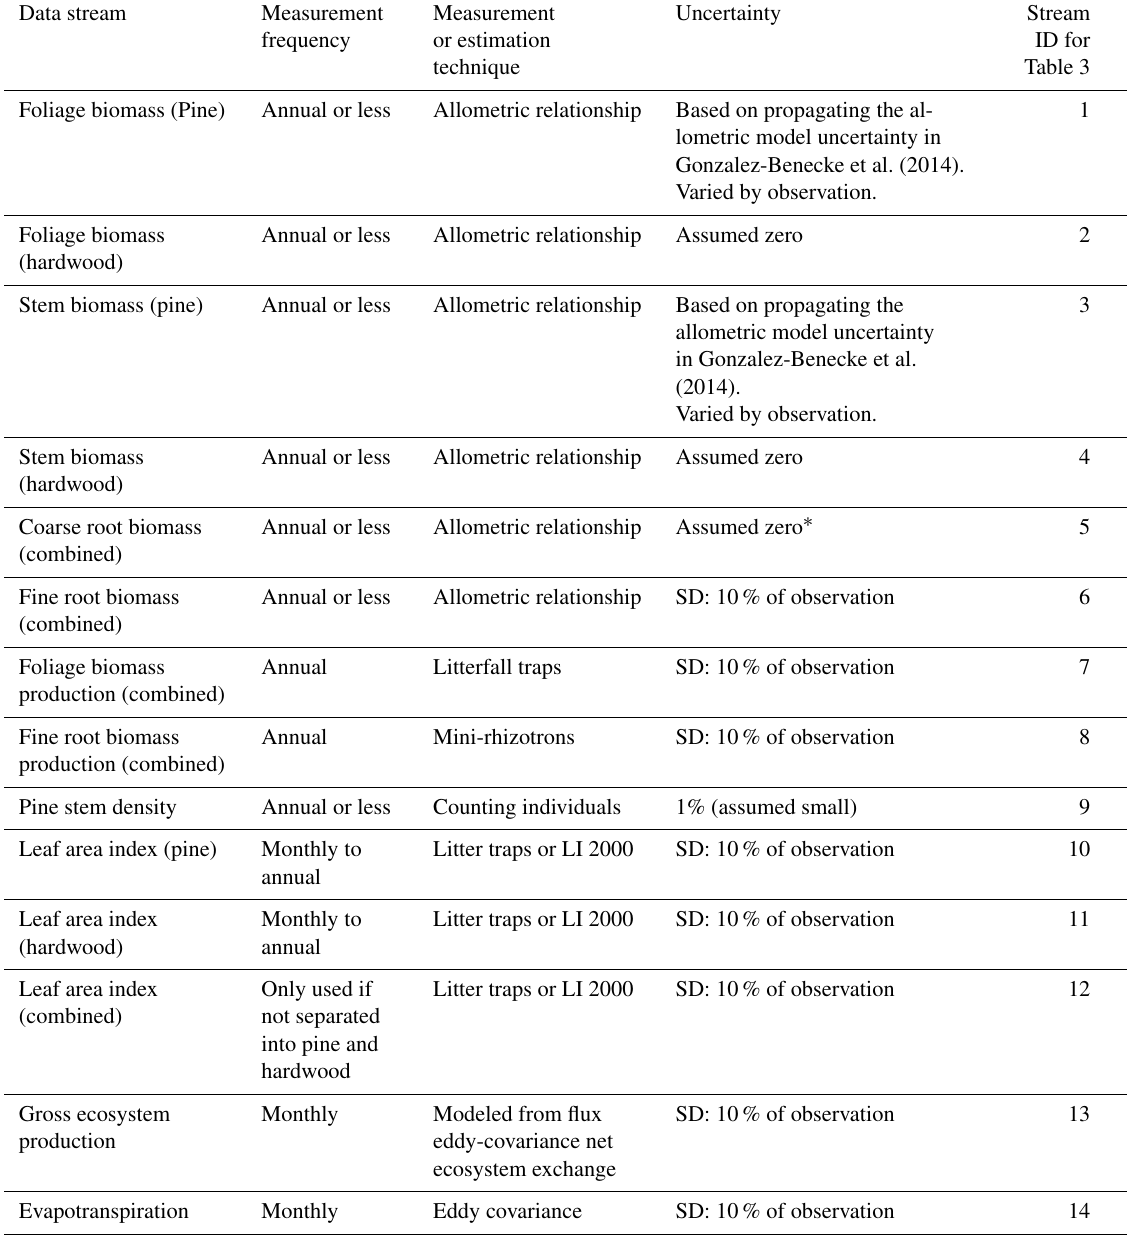
Table 1. Regional observational data streams used in data assimilation. Data stream